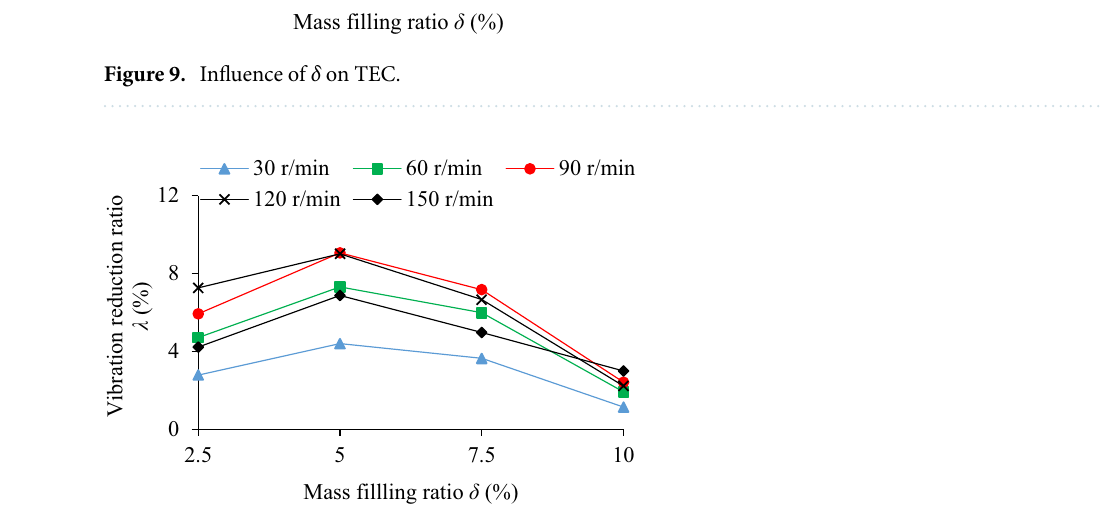
Figure 10. Influence of δ on